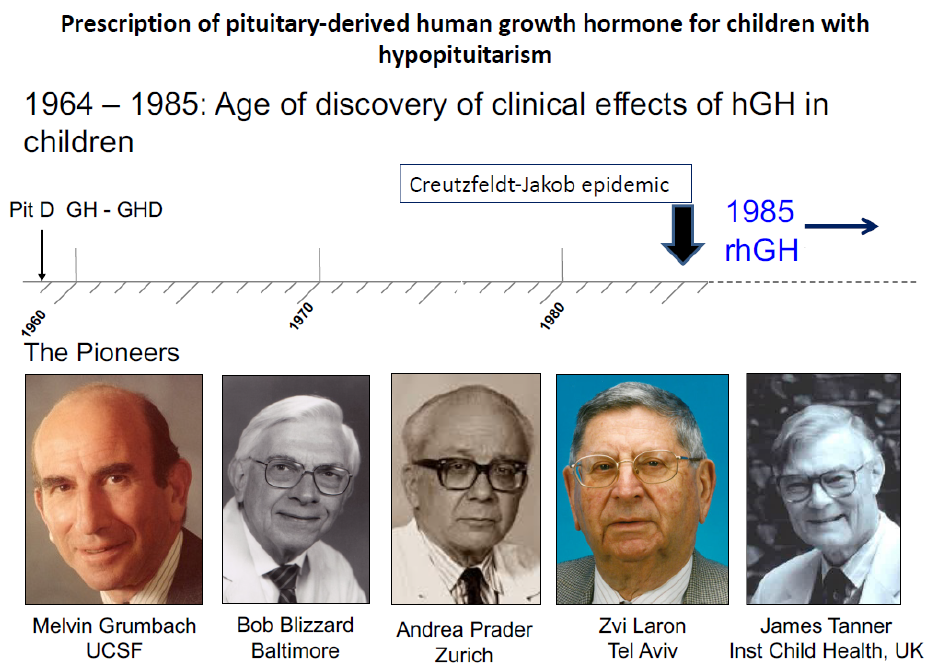
Figure 1. Treatment of hypopituitarism in children with pituitary-extracted human growth hormone. Some of the pioneering paediatric endocrinologists who prescribed this therapy.